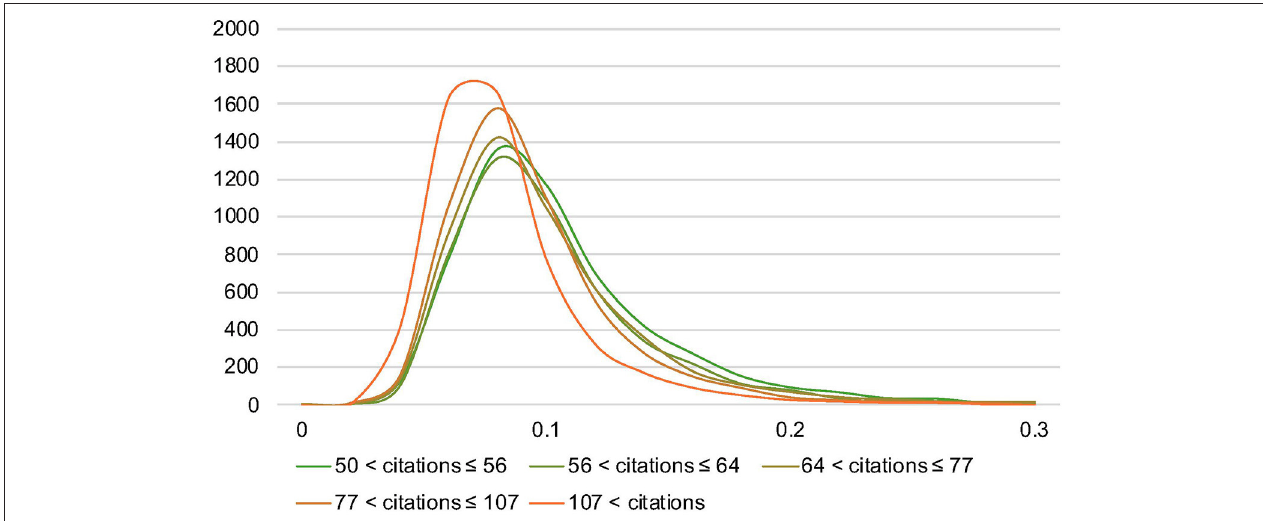
FIGURE 4 | The distribution of change score value over groups. This figure is a revised version from a workshop paper that was presented at CLBib-2017 (He and Chen, 2017).